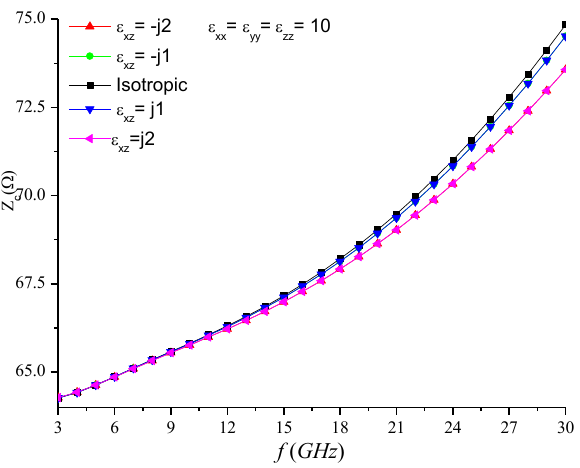
Figure 10.b: Effect of imaginary valued e xz on the characteristic